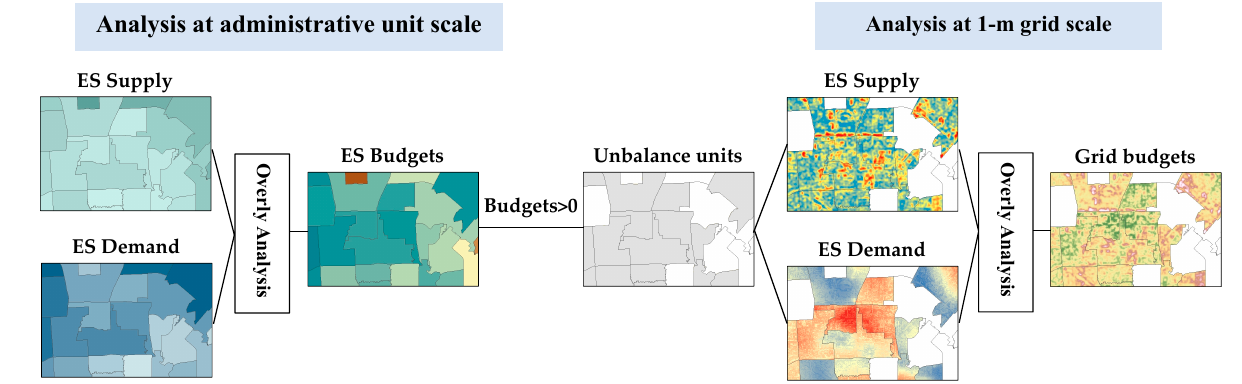
Figure 6. Analysis of the budgets of ecosystem service (ES) supply and demand at two scales.